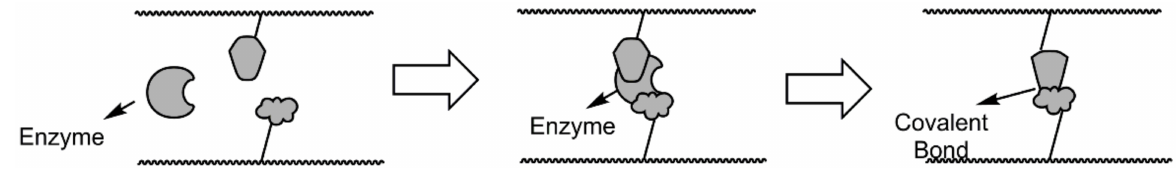
Figure 4. Schematic illustration of enzymatic